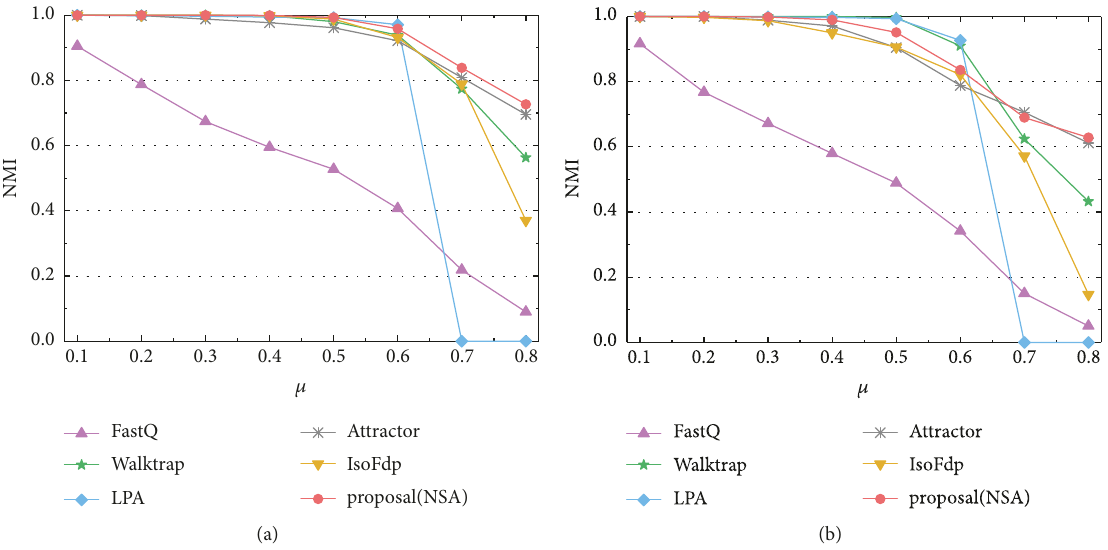
Figure 3: Comparison of differentcommunitydetection algorithms on LFR benchmark networks containing 5000nodes . (a)Theresults extracted from the larger networks with small-sized communities. (b) The results revealed from the larger networks with big-sized communities.